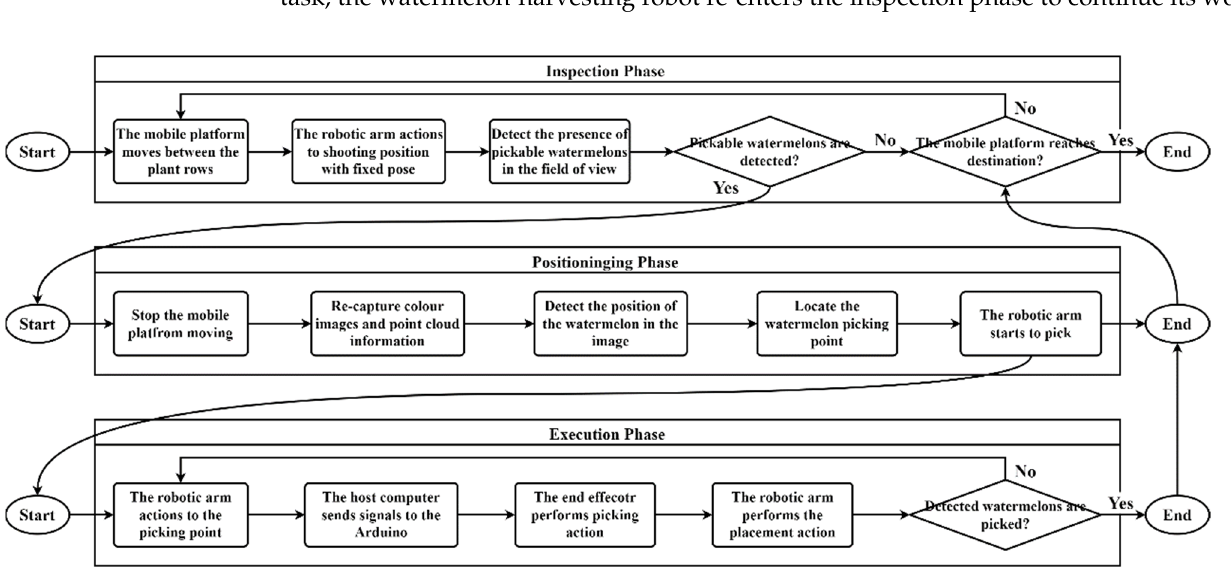
Figure 3. Workflow diagram of the watermelon-harvesting robot.